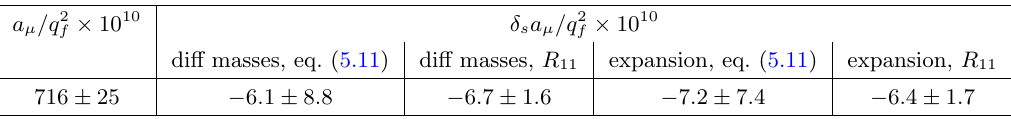
Table 10 . Summary of the results for the strong isospin breaking correction. The values shown in the table quote the di(cid:11)erence of the HVP contribution (cid:5) m d =q 2 our choices for the up and the down quark